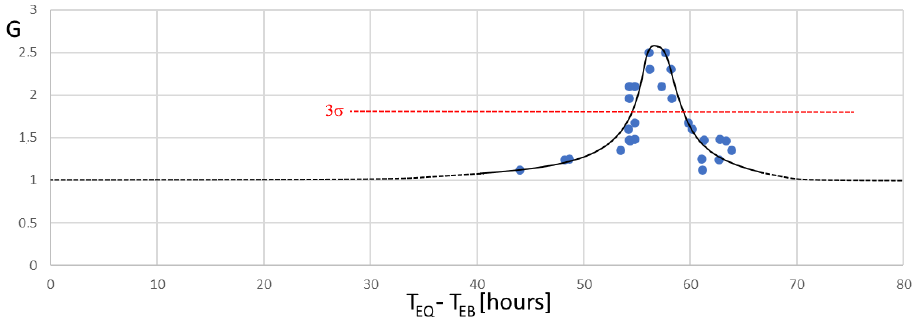
Figure 10. The probability gain approaching the correlation peak around 57 h; it was obtained by fitting the probability gain distribution from bin intervals of 1.5, 2, 2.5, 3, 4, 5, 6, 7, 8, 9, 10, 12, 14, and 17 h; the 3 sigmas limit is indicated by the red horizontal dashed.